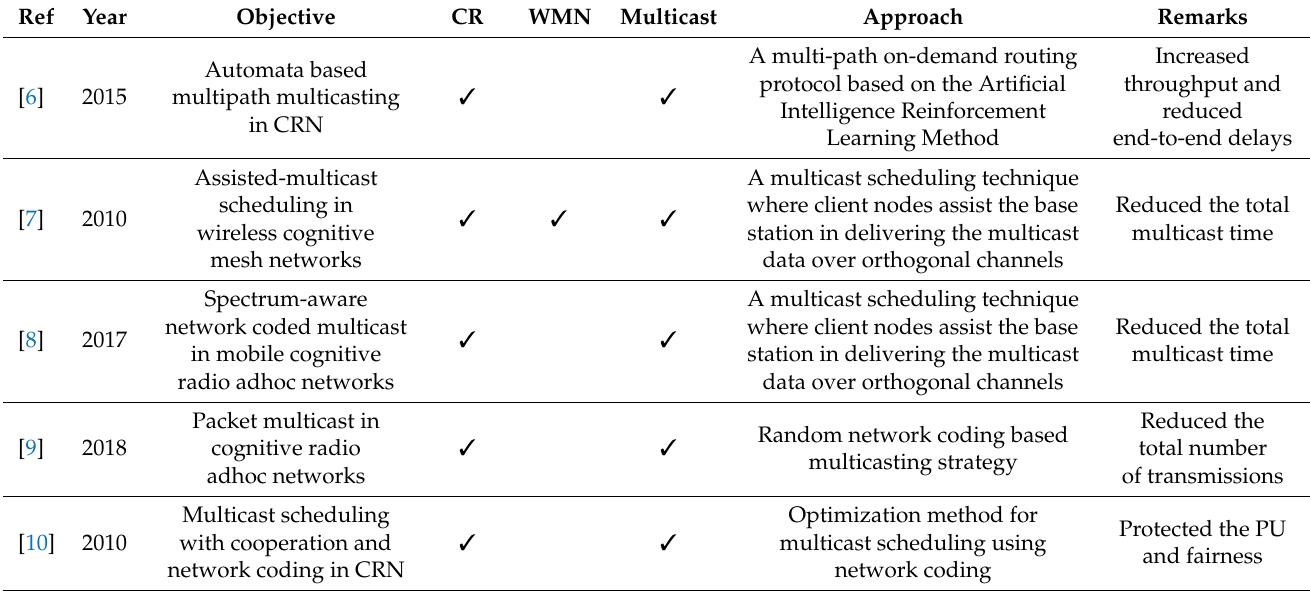
Table 1. Summary of Related